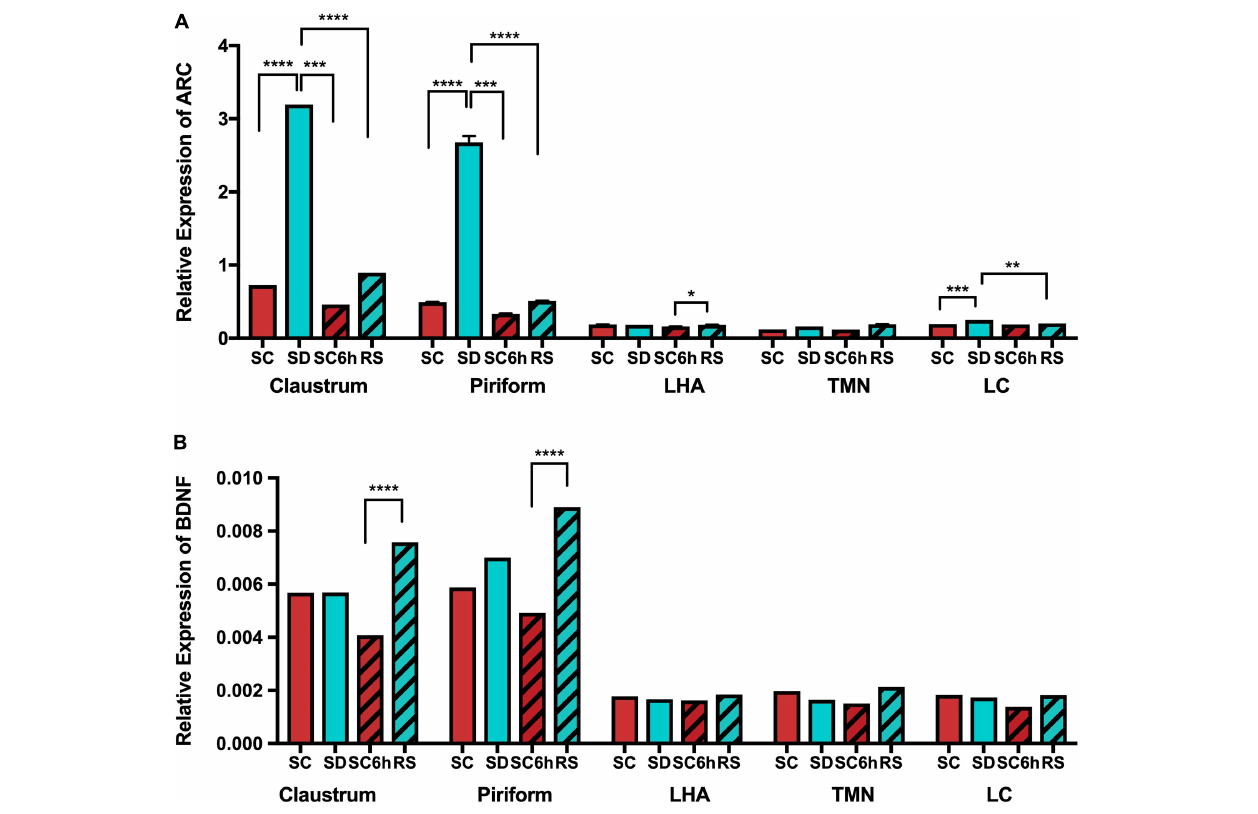
FIGURE 8 | QPCR shows increased Arc expression in claustrum and piriform cortex with SD. (A) Arc expression is shown across all conditions and brain regions. (B) BDNF expression is also shown across all brain regions and